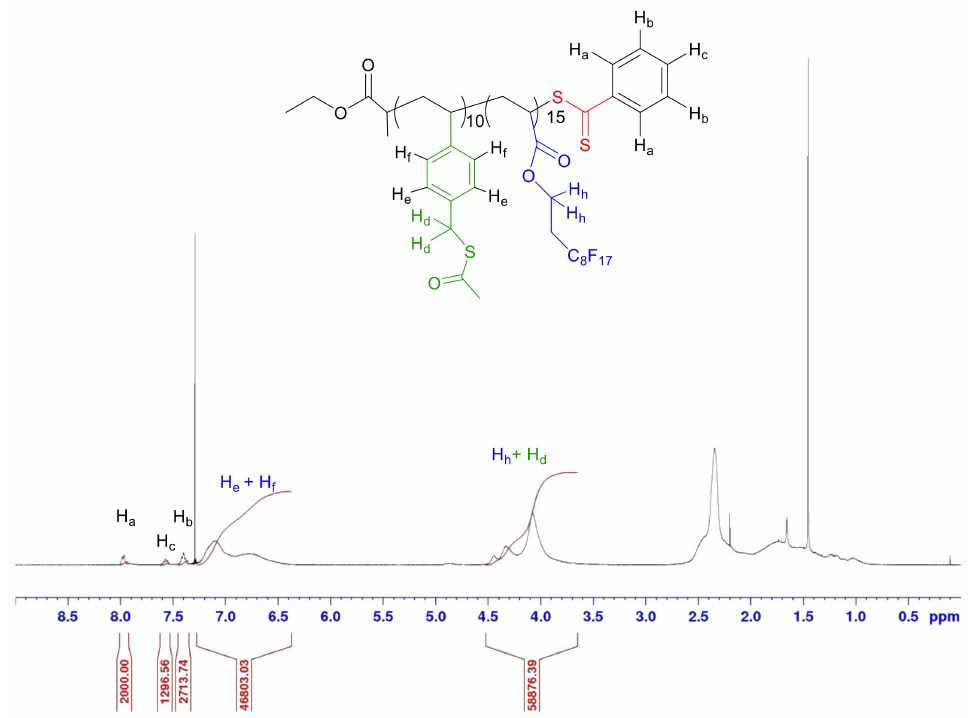
Figure 6. 1 H-NMR spectrum (400 MHz, CDCl 3 ) of P(StySAc- co -FDA) after